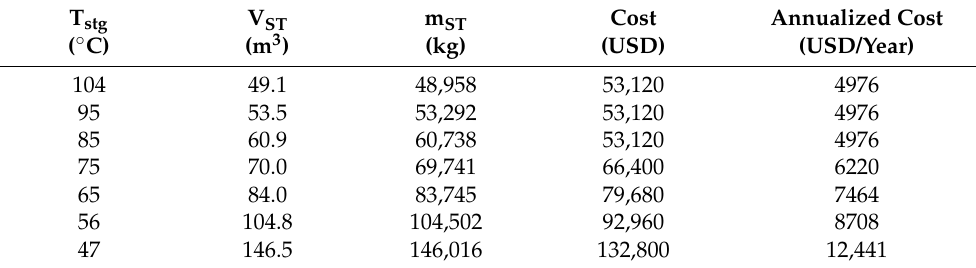
Table 2. Storage water required for the evaporation process of the heat pump.